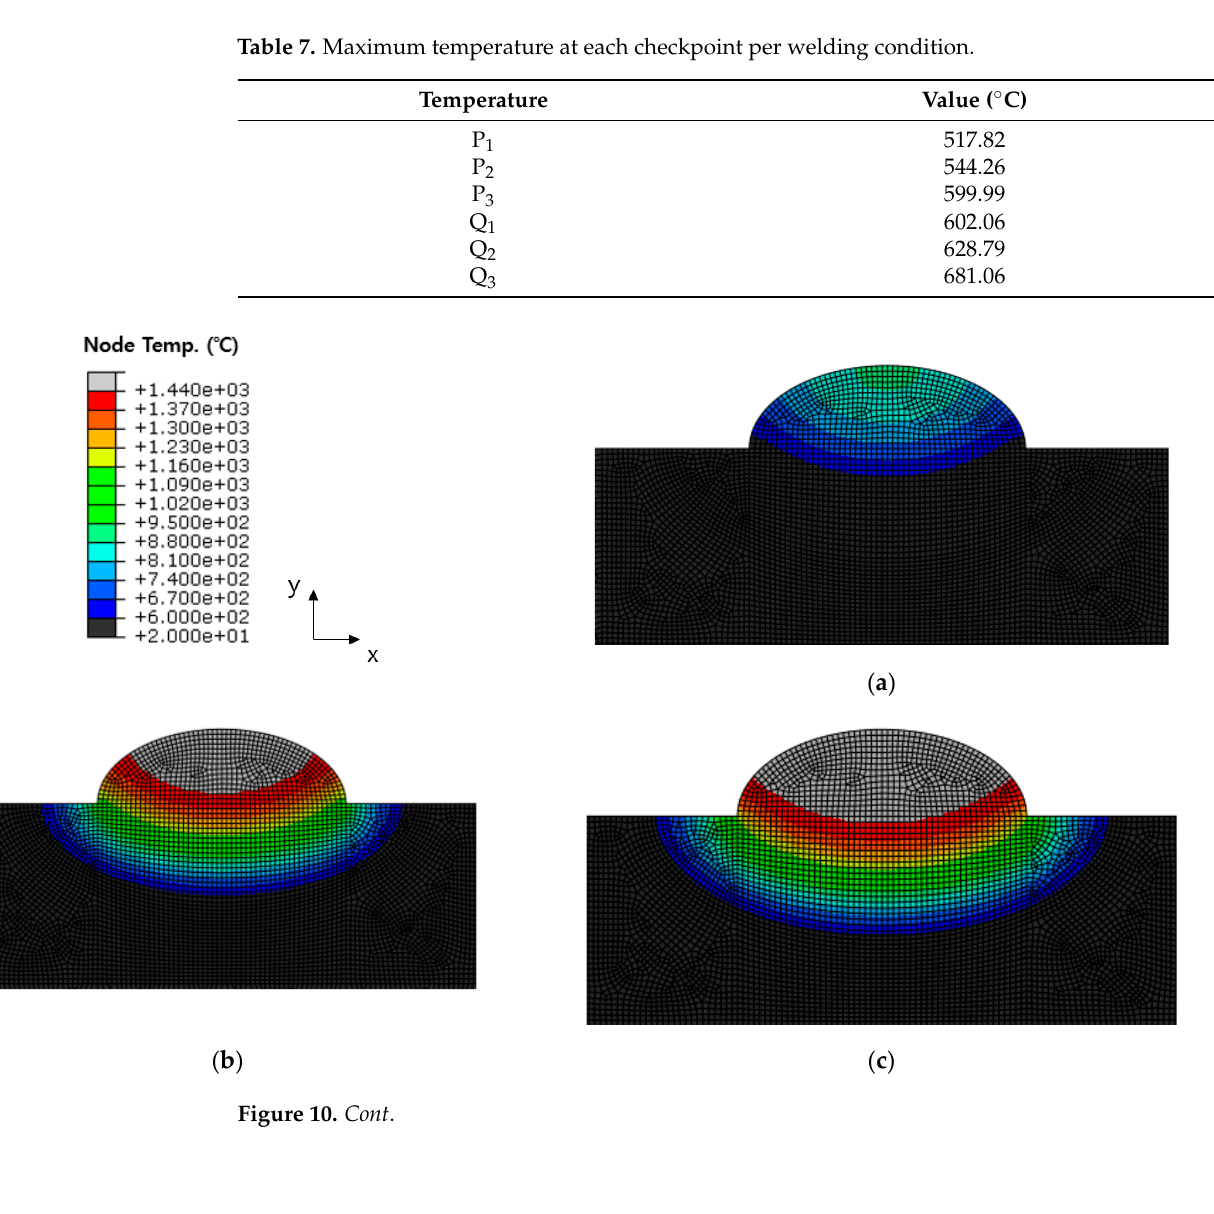
Table 6. Derived heat source parameters. Table 7. Maximum temperature at each checkpoint per welding condition .